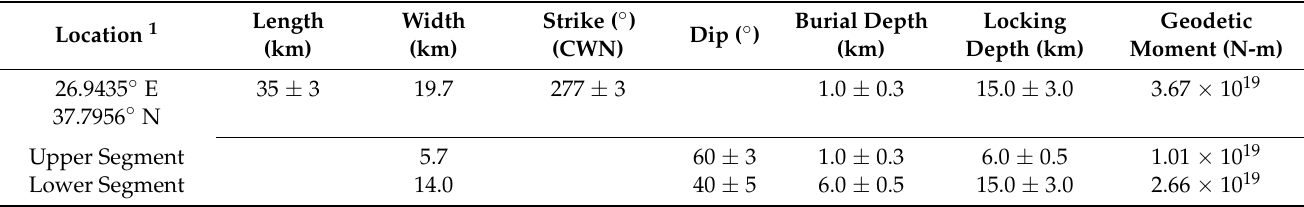
Table 4. Fault parameters of the best-fit